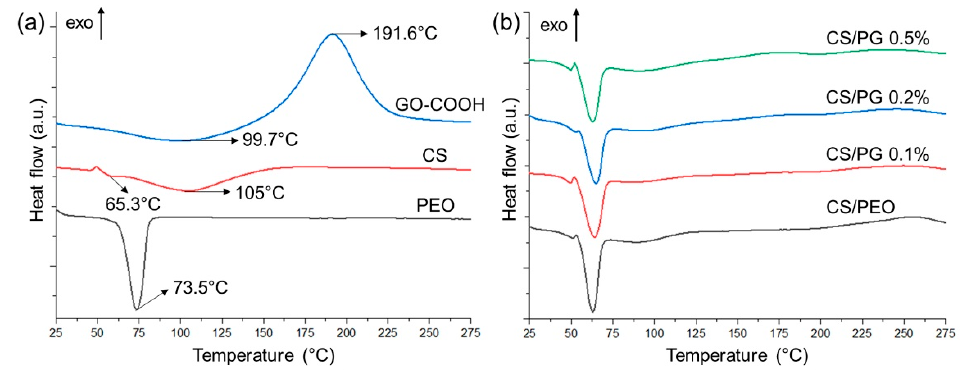
Figure 6. DSC curves of ( a ) raw materials (PEO, CS, GO-COOH); ( b ) crosslinked nanofibrous scaffolds. Table 4. Melting temperature (T m ) and melting enthalpy ( ∆ H m ) of the crosslinked nanofibrous scaffolds. Sample T m ( ◦ C) ∆ H m (J/g)